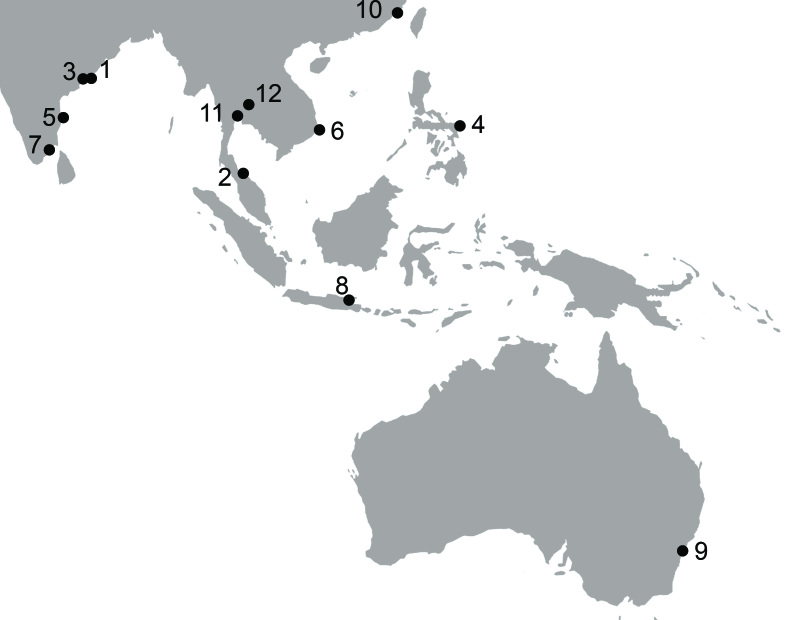
Distribution of Grandidierella
gilesi: 1. Chilika Lagoon, India (Chilton 1921); 2. Songkhla Lake (Tale Sap) and Pattani River and Malaysian State (Chilton 1925); 3. large creek close to Tumidalametta Hill at 102 m elev. in Vizagapatam, India (KHBarnard 1935); 4. Lapinig, Philippines (Schellenberg 1938); 5. Adyar, Madras Coast, India (Nayar 1959); 6. Nhatrang, Vietnam (Imbach 1967); 7. Pinnakayal, India (Sivaprakasam 1970); 8. Surabaya, Java, Indonesia (Ledoyer 1979); 9. Port Beacon, Brooklyn Gut, Hawksbury River, New South Wales (Myers 1981); 10. Qi'ao-Dan'gan Island Mangrove Nature Reserve on Qi'ao Island in the Pearl River Estuary, China (Wang et al. 2010); 11. Man-made freshwater pond in Kasetsart University, Bangkok, Thailand (Wongkamhaeng et al. 2016) and 12. Lam Tha Kong River, Thailand (present study).